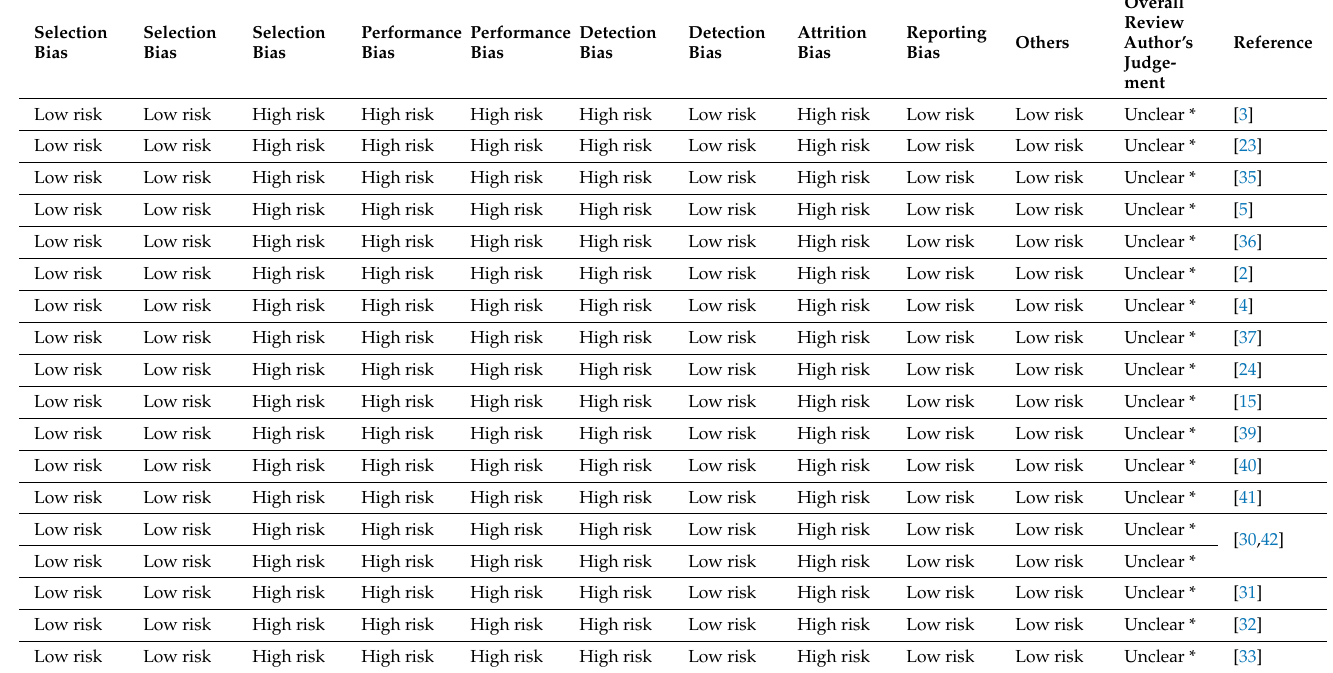
Table 7. Risk of bias assessment in case-controlled animal